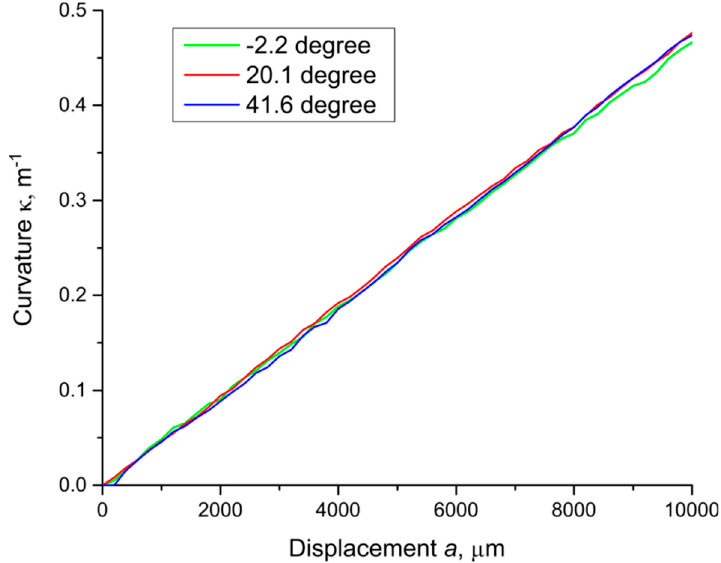
Figure 7. Experimentally obtained values of the curvature κ of the rod at the point of force application depending on the transverse deformation a for three different values of the angle θ .